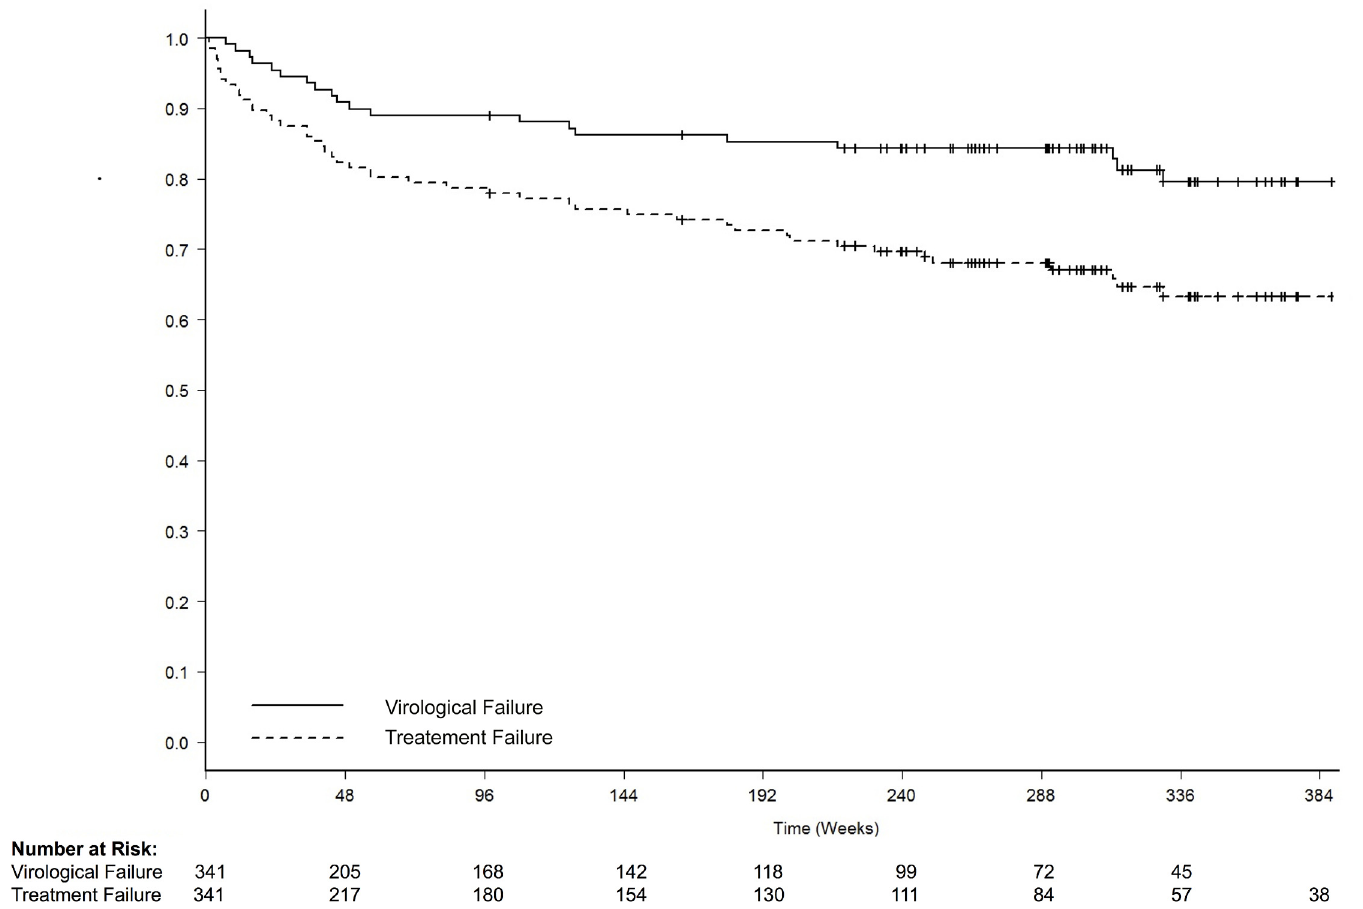
Fig 1. Time to virological failure and treatment failure through the long term follow-up. Virological failure was defined as two consecutive measurements of pVL > 50 copies/mL. Treatment failure included subjects with virological failure, treatment discontinuations due to drug toxicity, and death.